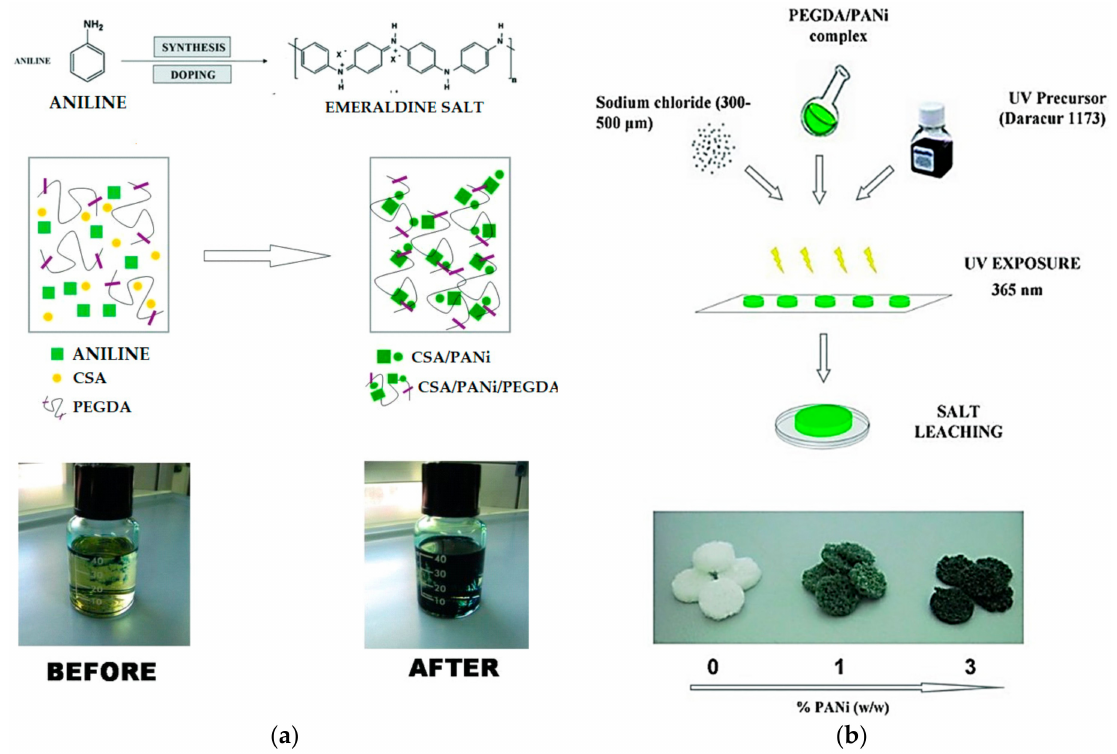
Figure 5. ( a ) In situ CSA-PANi synthesis in PEGDA solution and ( b ) preparation of PANi/PEGDA microporous hydrogels (reproduced from [80] with permission, copyright Wiley,